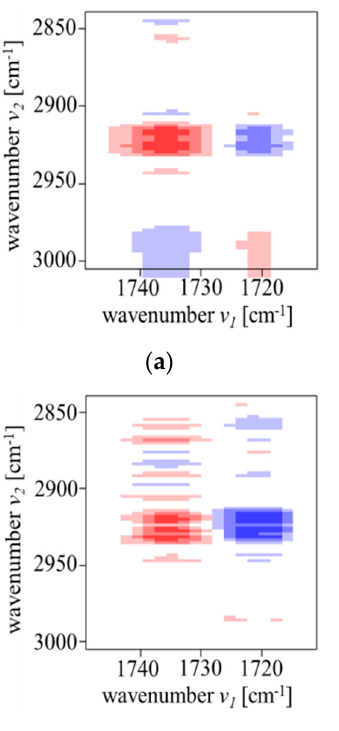
( f ) Figure 10. 2D-COS correlation ( a – c ) synchronous and ( d – f ) asynchronous maps of 3F7HPhH7 in the heating mode from 249 to 299 K in the wavenumber regions of: ( a , d ) 3000–2840 cm –1 , ( b , e ) 1770–1670 cm –1 and ( c , f ) 1400–1000 cm –1 . The red or blue areas represent positive or negative correlation intensities, respectively. The generalized 2D-COS correlation analysis is presented in Figure 11, in the region of 1750–